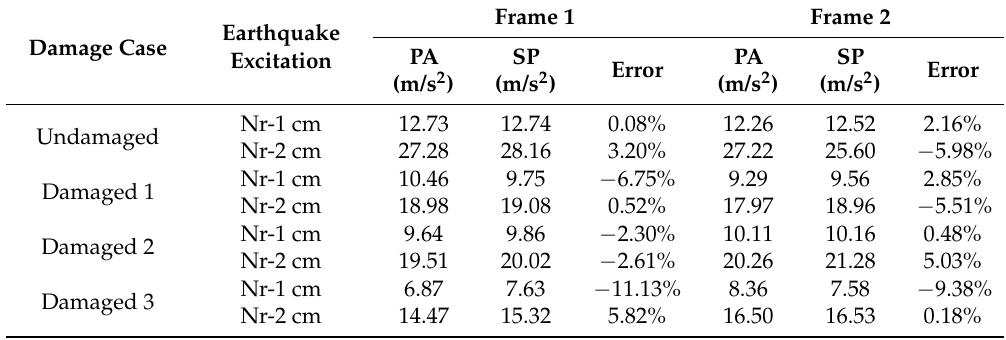
Table 3. Peak values of acceleration under different excitation levels by two kinds of sensors.